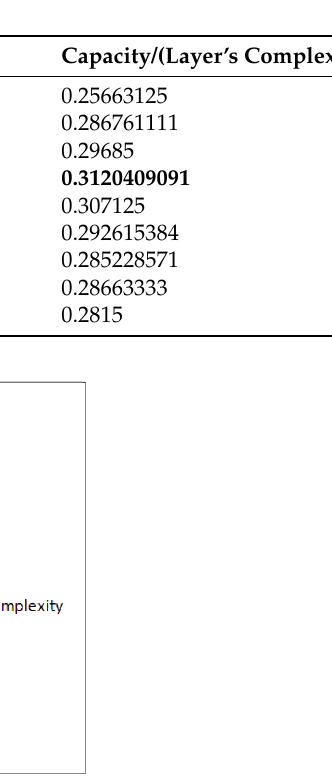
Table 1. Accuracy, capacity and capacity/(layer’s complexity) with a varying number of filters in the hidden layer. The layer’s complexity is shown by the number of filters. The optimal ratio appears at 22 conv. filters.